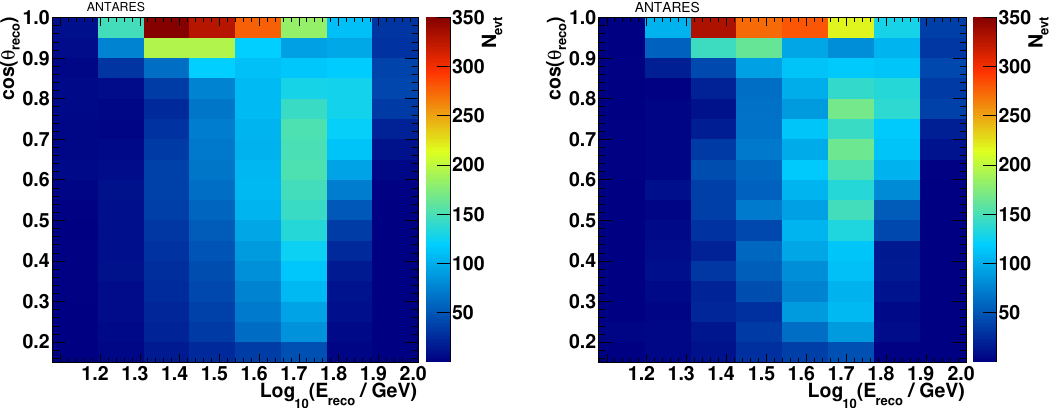
Figure 4 . Number (colour scale on the right side) of selected MC events assuming no oscillation (left panel) and selected data (right panel), binned according to the logarithm of the reconstructed energy, log ( E reco = GeV), and the reconstructed cosine of zenith, cos (cid:18) reco . The (cid:12)rst energy bin 10 contains all events with log ( E reco = GeV) < 1 : 10